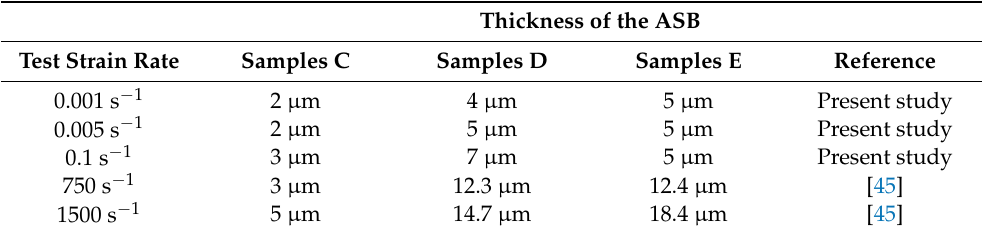
Thickness of the ASB